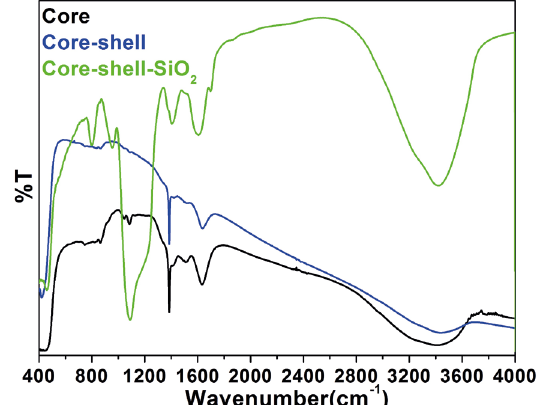
Figure 4. FTIR spectra of the Core, core-shell and core-shell-SiO